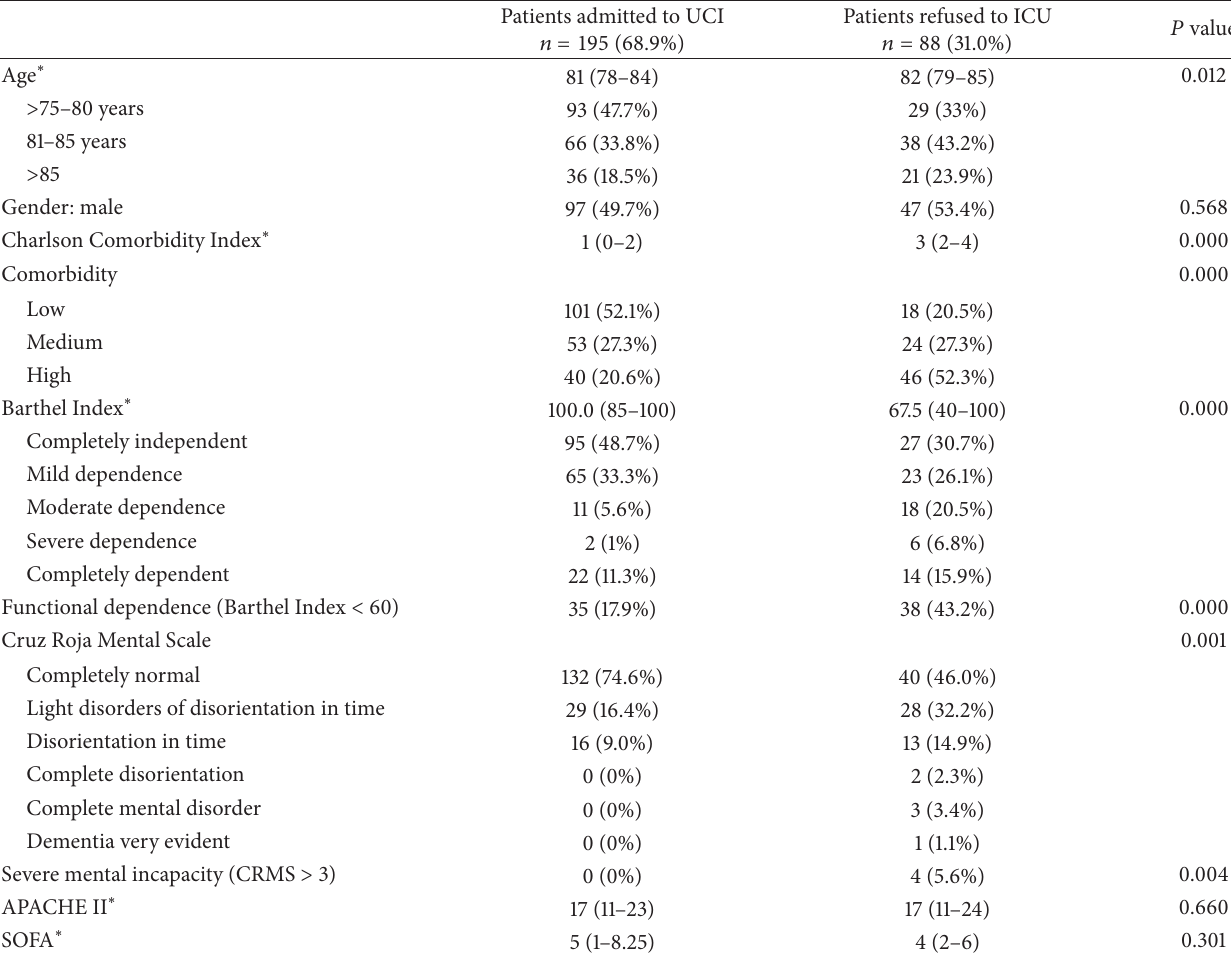
Table 4: Baseline characteristics of patients who were candidates to